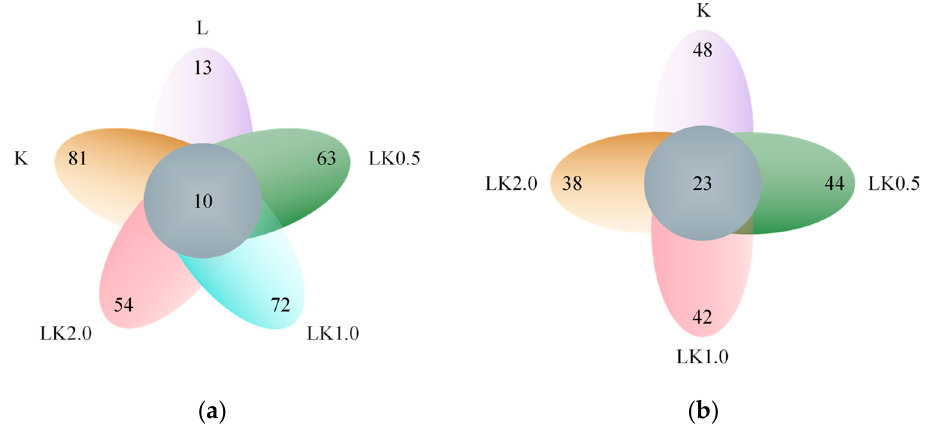
Figure 2. Venn diagrams for ( a ) bacteria and ( b ) fungi showing the number of species in each sample and those shared by all samples.